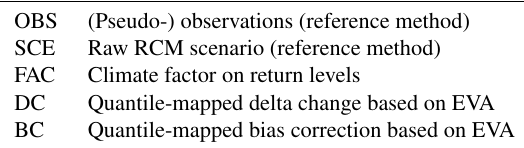
Table 2. Overview of methods used in the